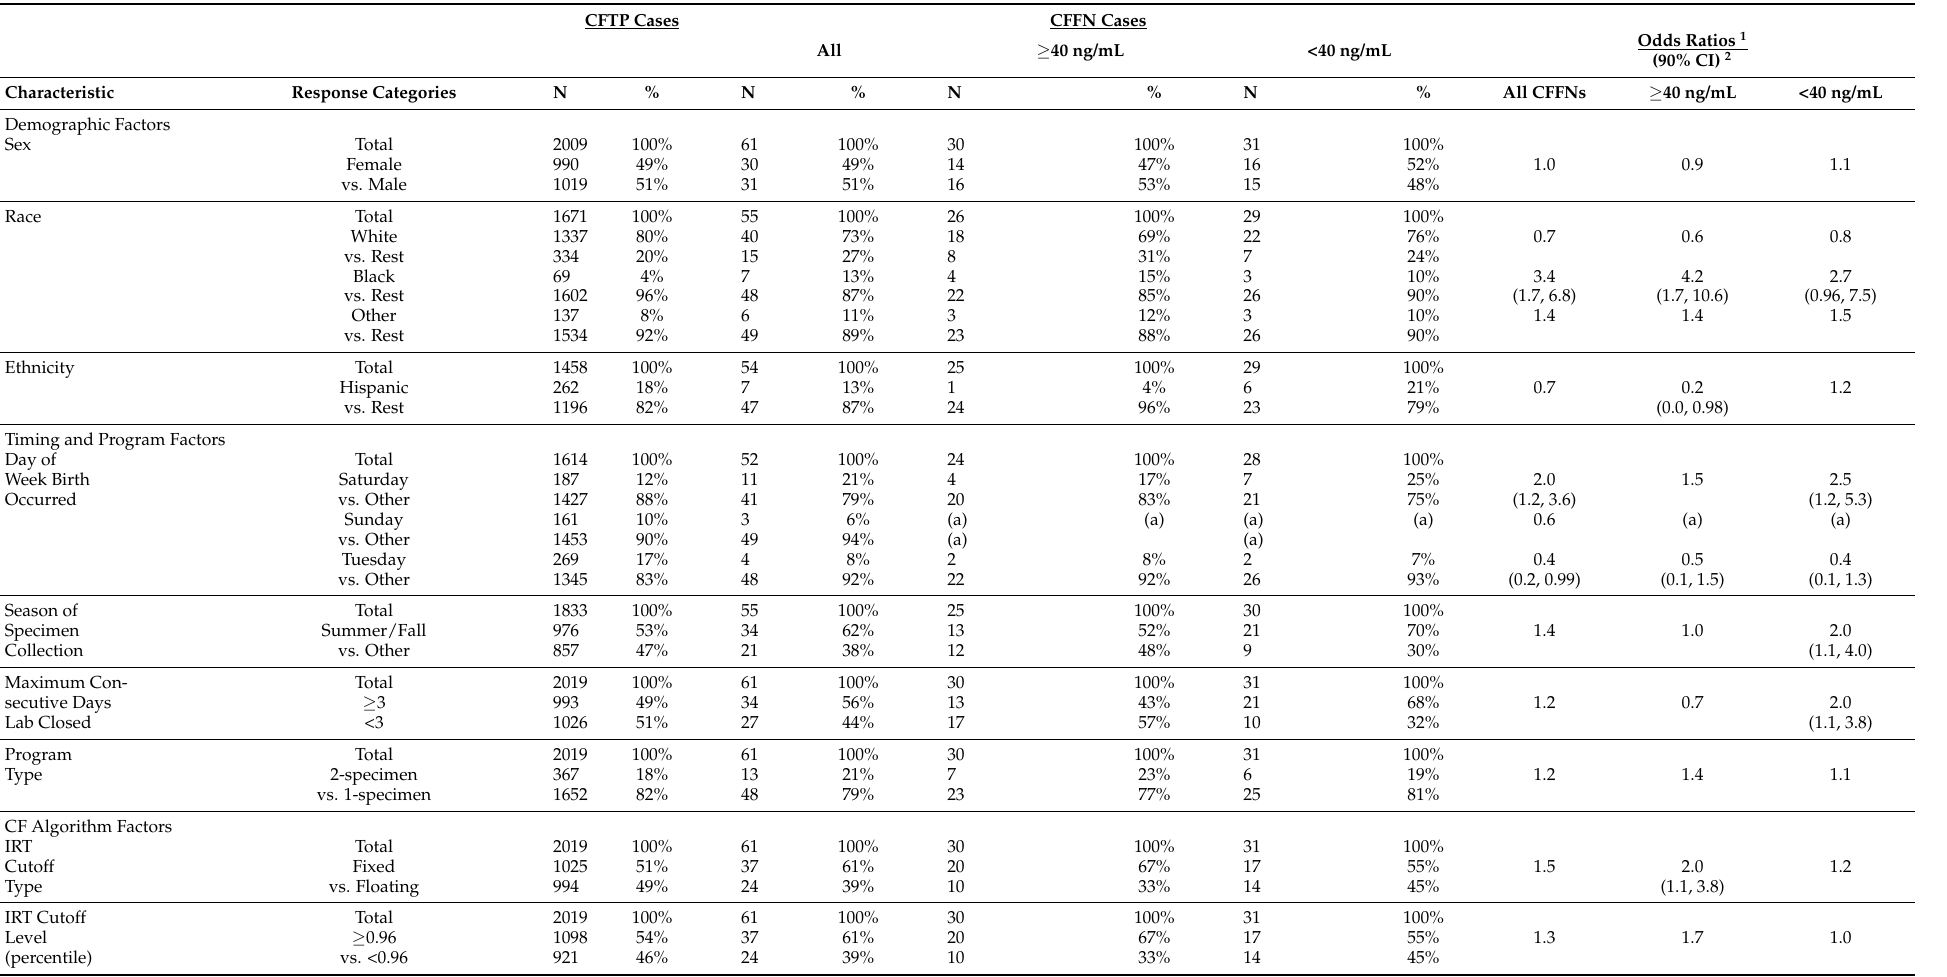
Table 3. Number, percentage and odds ratios (90% confidence intervals) for study factors in CFTP, CFFN, CFFN ≥ 40 ng/mL and CFFN <40 ng/mL study